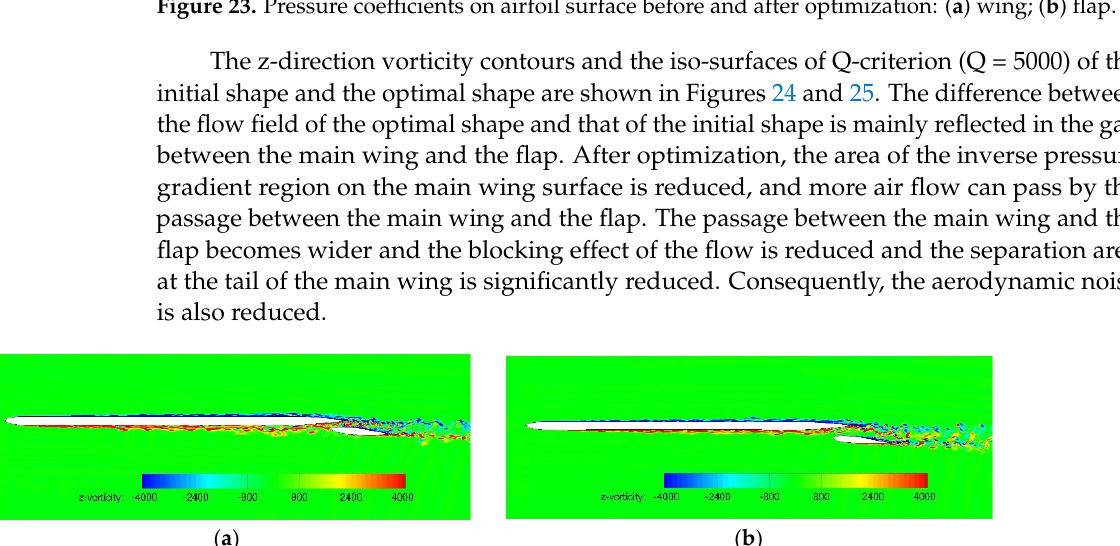
Figure 23. Pressure coefficients on airfoil surface before and after optimization: ( a ) wing; ( b ) flap. The z-direction vorticity contours and the iso-surfaces of Q-criterion (Q = 5000) of the